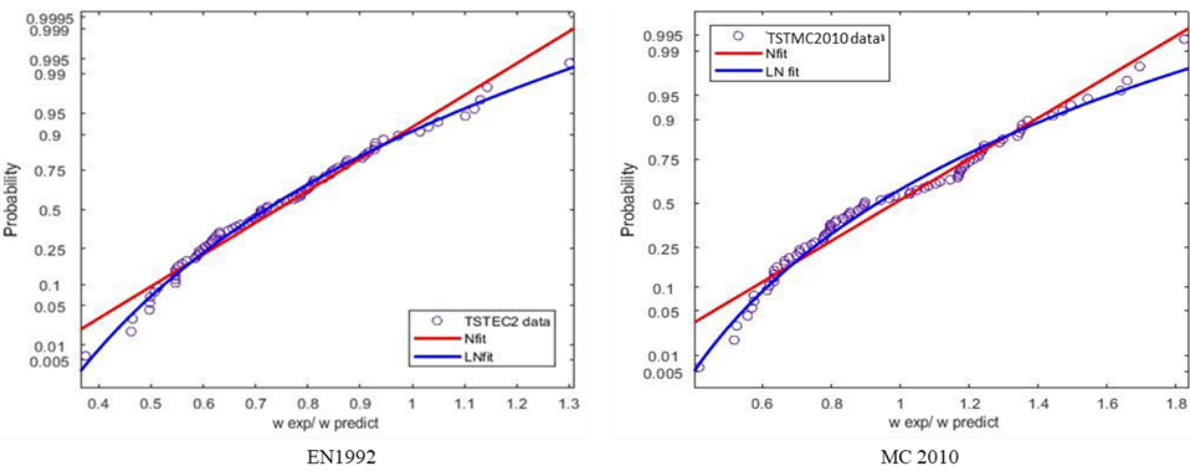
Figure 1. Probability Plots for EN 1992 and MC 2010 - short-term tension